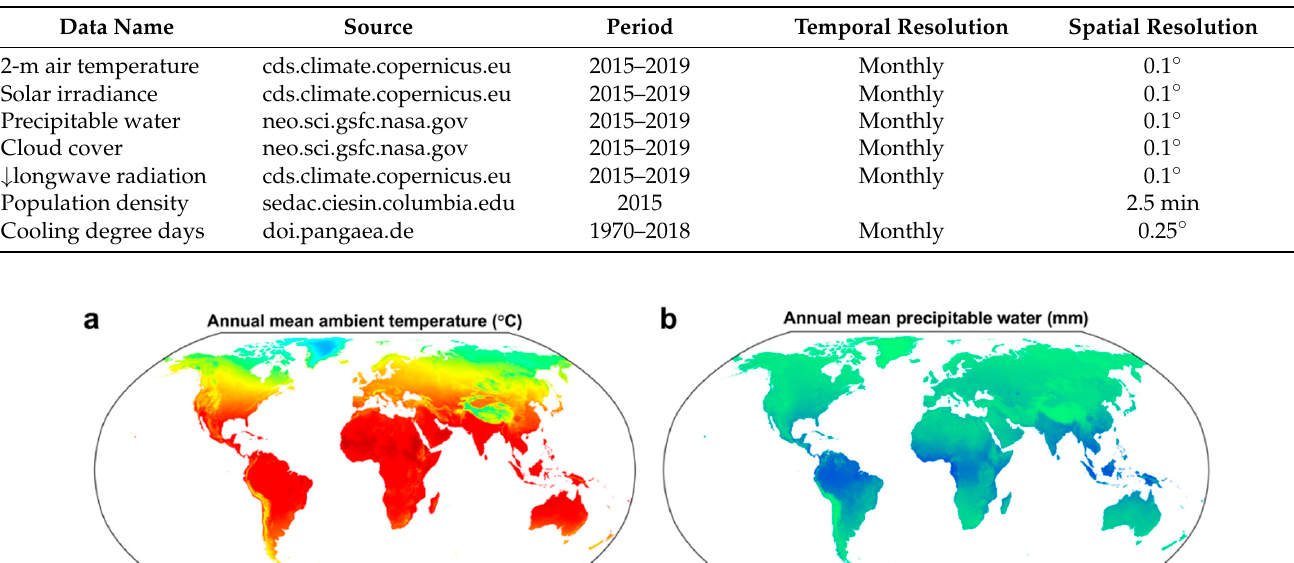
Table 2. Information of input global datasets.